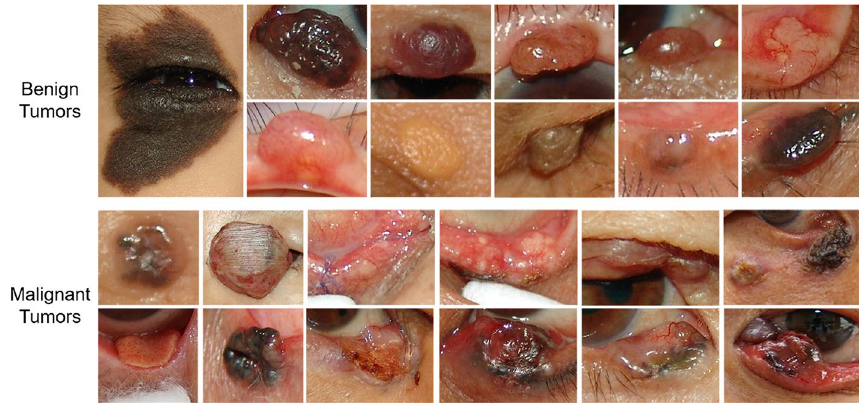
Fig. 3 Input samples of benign and malignant